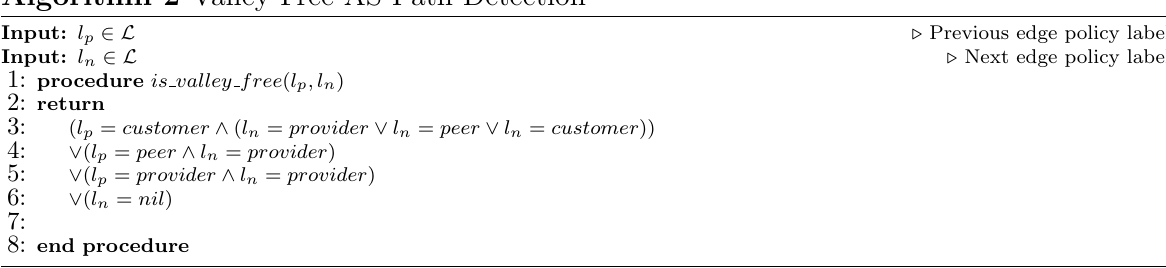
Algorithm 2 Valley-Free AS Path